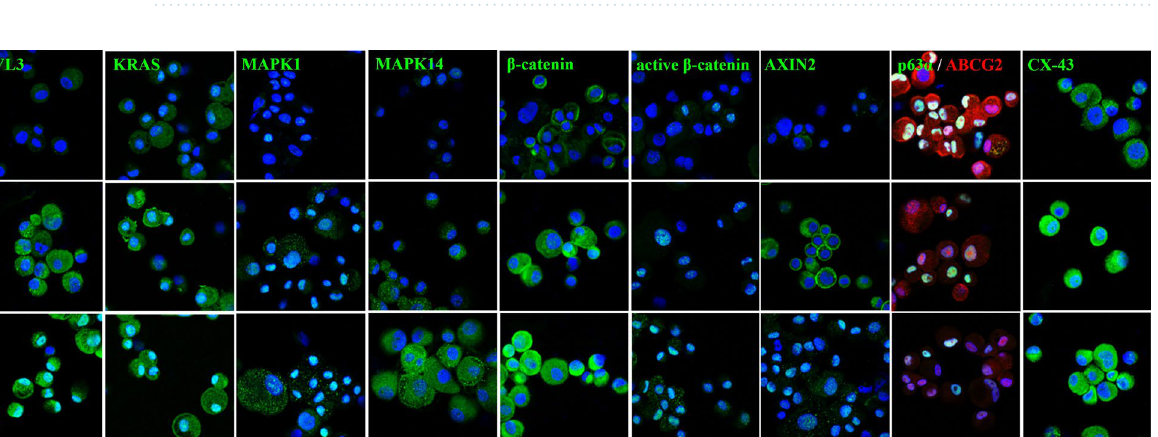
Figure 2. Protein expression profile of hsa-miR-143-3p transfected cells grown in 2D culture system. ( a ) Representative Western blots of protein of interest in three groups-hsa-miR-143-3p mimic, inhibitor and control (n = 3): (i) hsa-miR-143-3p targets: DVL3, KRAS, MAPK1 and MAPK14, (ii) stem cell markers: ABCG2 and ΔNp63α (iii) differentiation marker: Cx43, (iv) Wnt signaling regulators: AXIN2, β-catenin and active β-catenin and (v) MAPK signaling regulators: p-ERK1/2, p-p38, p–c-JUN, p–c-FOS, p-ATF2 and p-p53. GAPDH was used as normalising reference and loading control. Bar graphs indicating the relative expression profile of the proteins quantified by Western blotting ( b ) hsa-miR-143-3p targets ( c ) Stem cell markers ( d ) Differentiation marker ( e ) Wnt signaling regulators ( f ) MAPK signaling regulators. * P < 0.05; ** P < 0.001. The relative protein expression values are provided in Table S4 and original Western blots images are provided in Fig. S2.